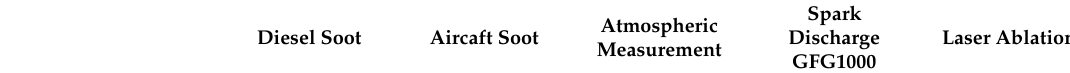
Table 1. The characteristic performances of soot generated by different methods. Related references